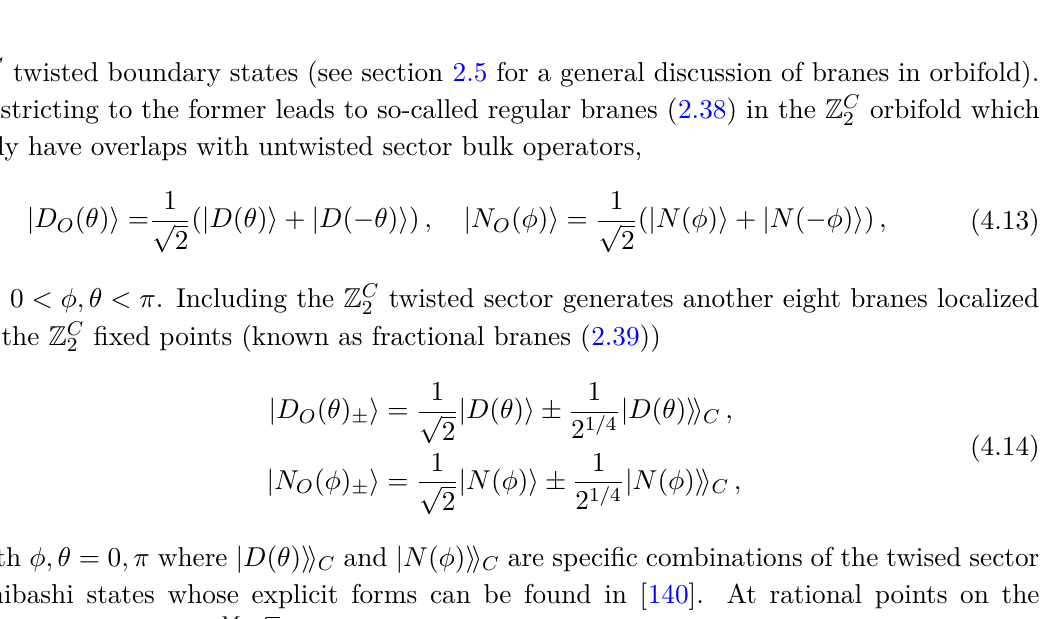
Table 2. Bulk and boundary gaps and brane tensions on the c = 1 orbifold